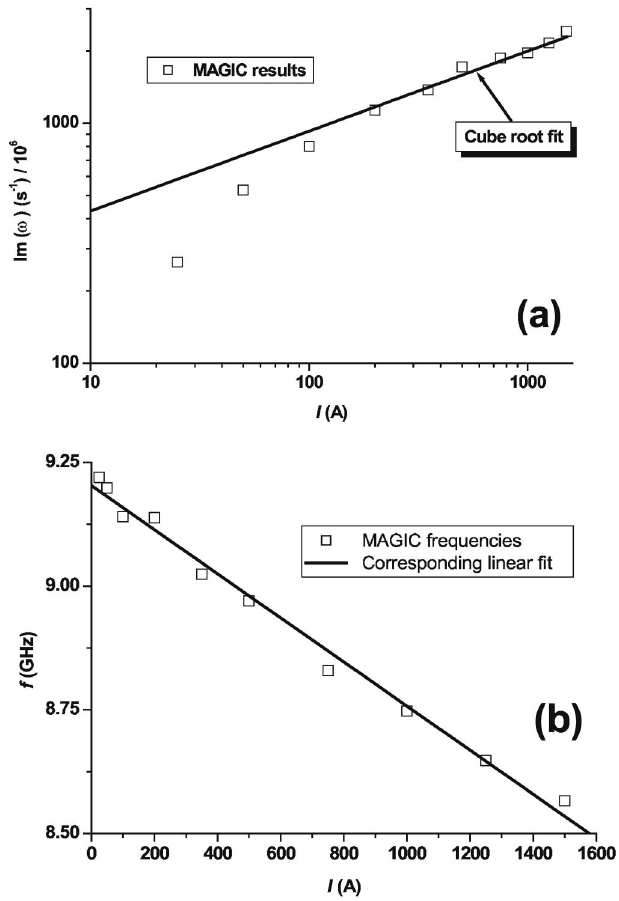
FIG. 9. (a) Temporal gain Im (cid:6) 2 ! (cid:8) as a function of current (b) CSP frequency as a function of current.